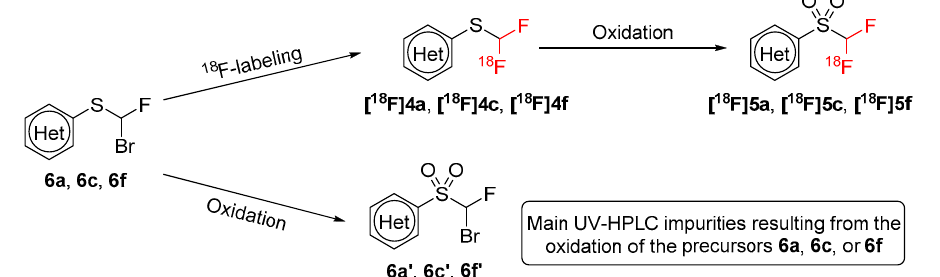
Scheme 4. Formation of the by-products 6a' , 6c’ , and 6f’ by oxidation of the precursors 6a , 6c , and 6f , respectively.